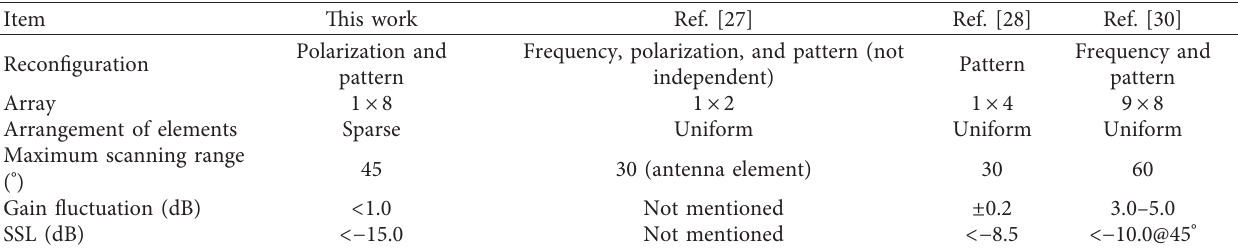
Table 4: Radiation performance of the RPA array.